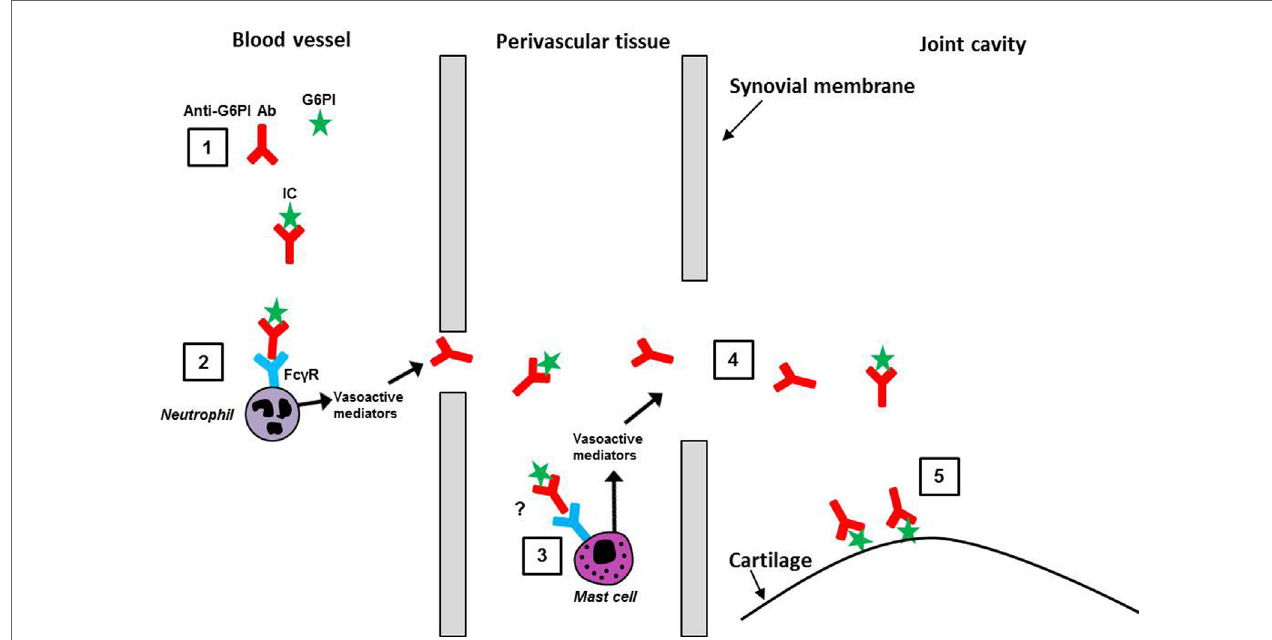
FiGURe 1 | The “initiation phase” of the K/BxN STA model . A summary of some of the literature on the early stages of K/BxN STA progression, leading to the formation of anti-G6PI/G6PI ICs in the joint, is depicted. (1) In the blood, the anti-G6PI antibodies (Ab) bind to G6PI and form the ICs. (2) On neutrophils, for example, the ICs bind to Fc γ -receptors (Fc γ R) triggering the release of vasoactive mediators and the local increase in vascular permeability, thus allowing ICs and anti-G6PI Abs to enter the perivascular tissue in the joint. (3) In the perivascular tissue, the ICs might bind to Fc γ Rs on mast cells causing them to degranulate, resulting in enhanced vascular permeability. (4) ICs, anti-G6PI Abs, non-specific Abs (not shown) and serum proteins (not shown) enter the joint cavity, where (5) anti-G6PI Abs bind to G6PI expressed on the cartilage